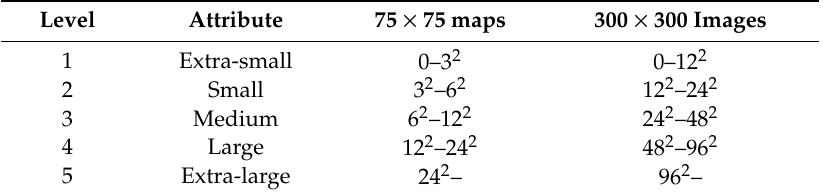
Table 2. Correspondence size in 300 × 300 images and 75 × 75 feature maps of